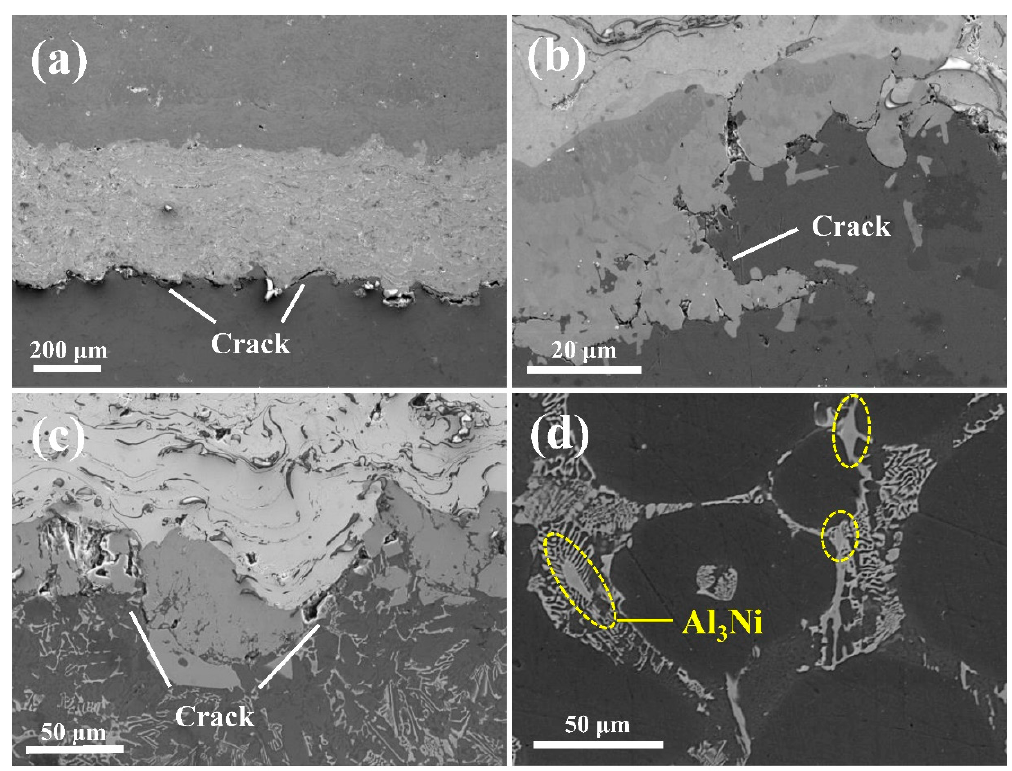
Figure 7. ( a – c ) SEM micrographs of the Al/Fe alloys hybrid structure’s interface under different solution temperature, followed by air cooling; ( a ) 500 °C, ( b ) 530 °C, and ( c ) 550 °C. ( d ) The precipitated Al 3 Ni at the matrix after 550° C heat treatment, followed by air cooling.